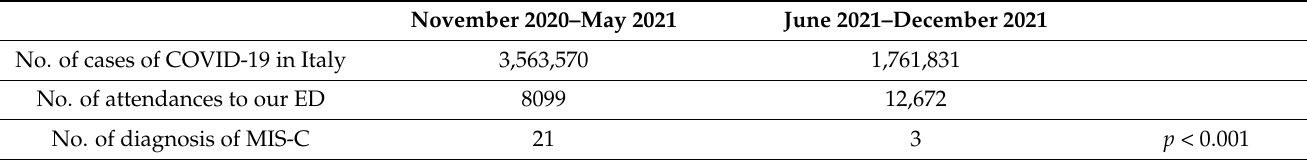
Table 2. MIS-C presentation during high and low COVID-19 circulation periods.